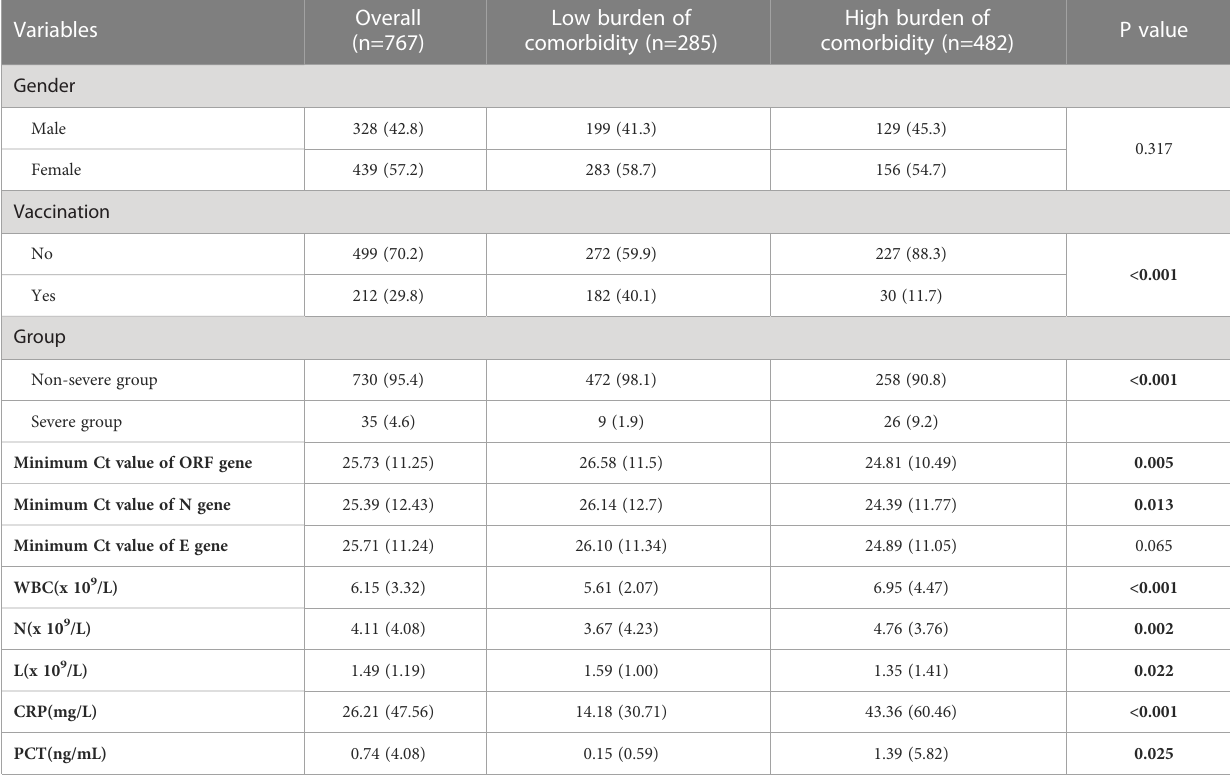
TABLE 1 Characteristics of COVID-19 patients according to the overall burden of comorbidity . Variables